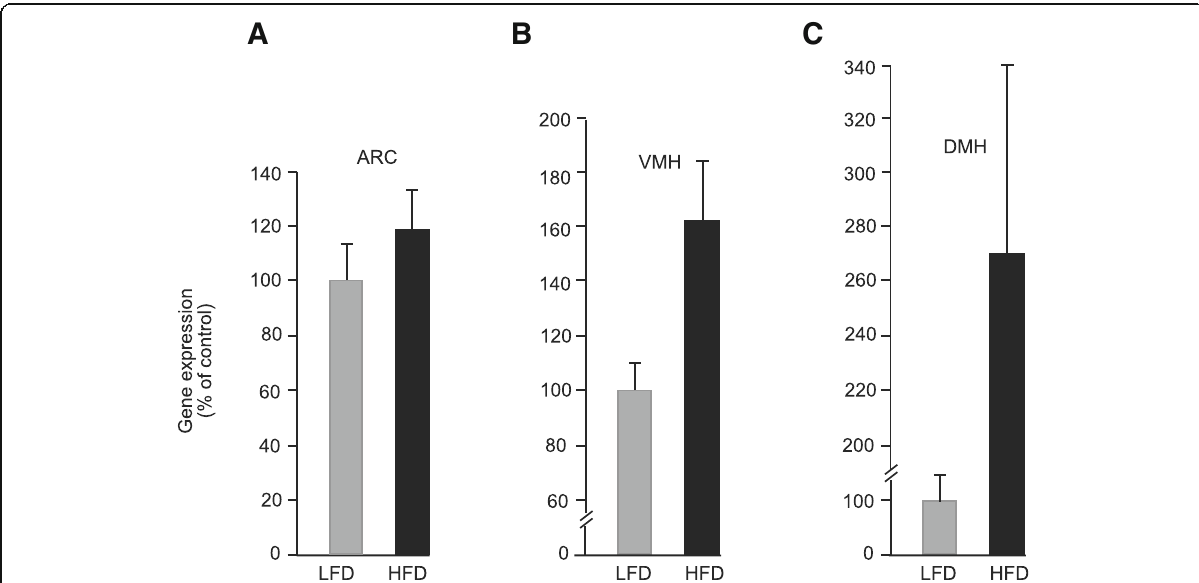
Fig. 7 Levels of serpinA3N gene expression measured by semi-quantitative in situ autoradiography in the a arcuate nuclei (ARC), b ventromedial nuclei of the hypothalamus (VMH) and c dorsomedial nuclei of the hypothalamus (DMH) in IL-1R1 − / − mice on a C57BL/6J background fed either a LFD or HFD for 8 weeks ( n = 9 for HFD and n = 5 for